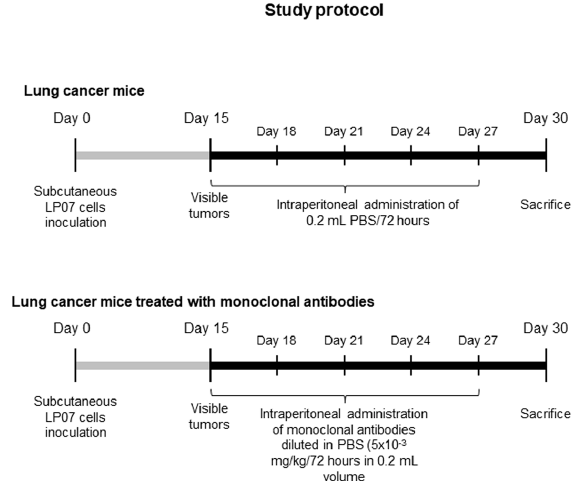
Figure 1. Graphical time-line representation of the non-treated control lung cancer mice and